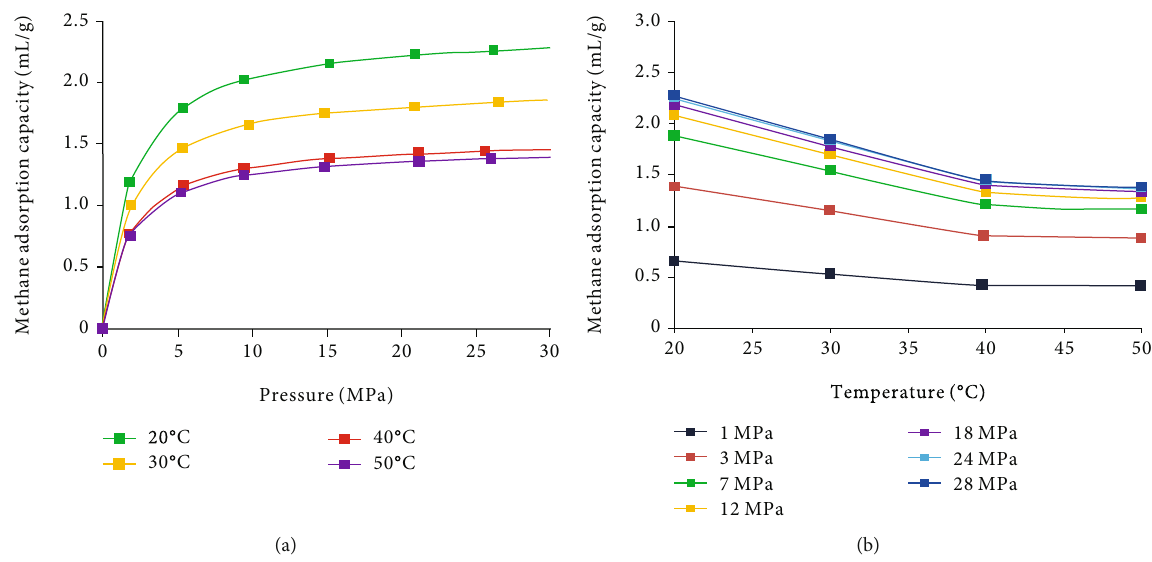
Figure 12: E ff ect of pressure and temperature on methane adsorption capacity. (a) As the pressure increases, the methane adsorption capacity gradually increases, and the increasing trend decreases after 5 MPa. (b) As the temperature increases, the methane adsorption capacity gradually decreases, and after 40 ° C, the increase rate